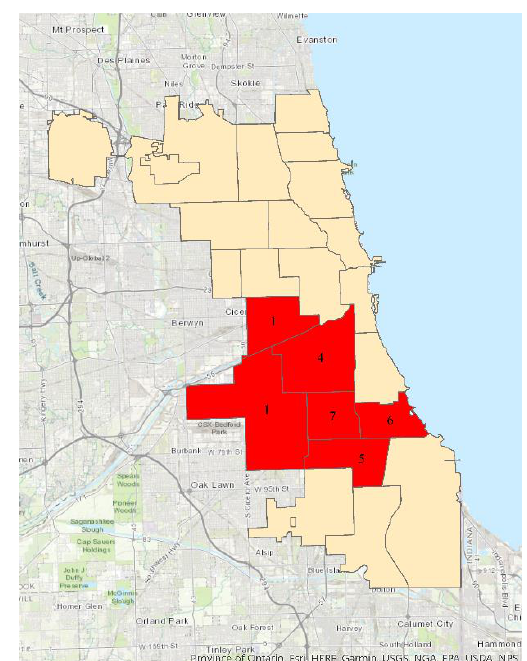
Figure 7. High value clusters by weekday at police district level